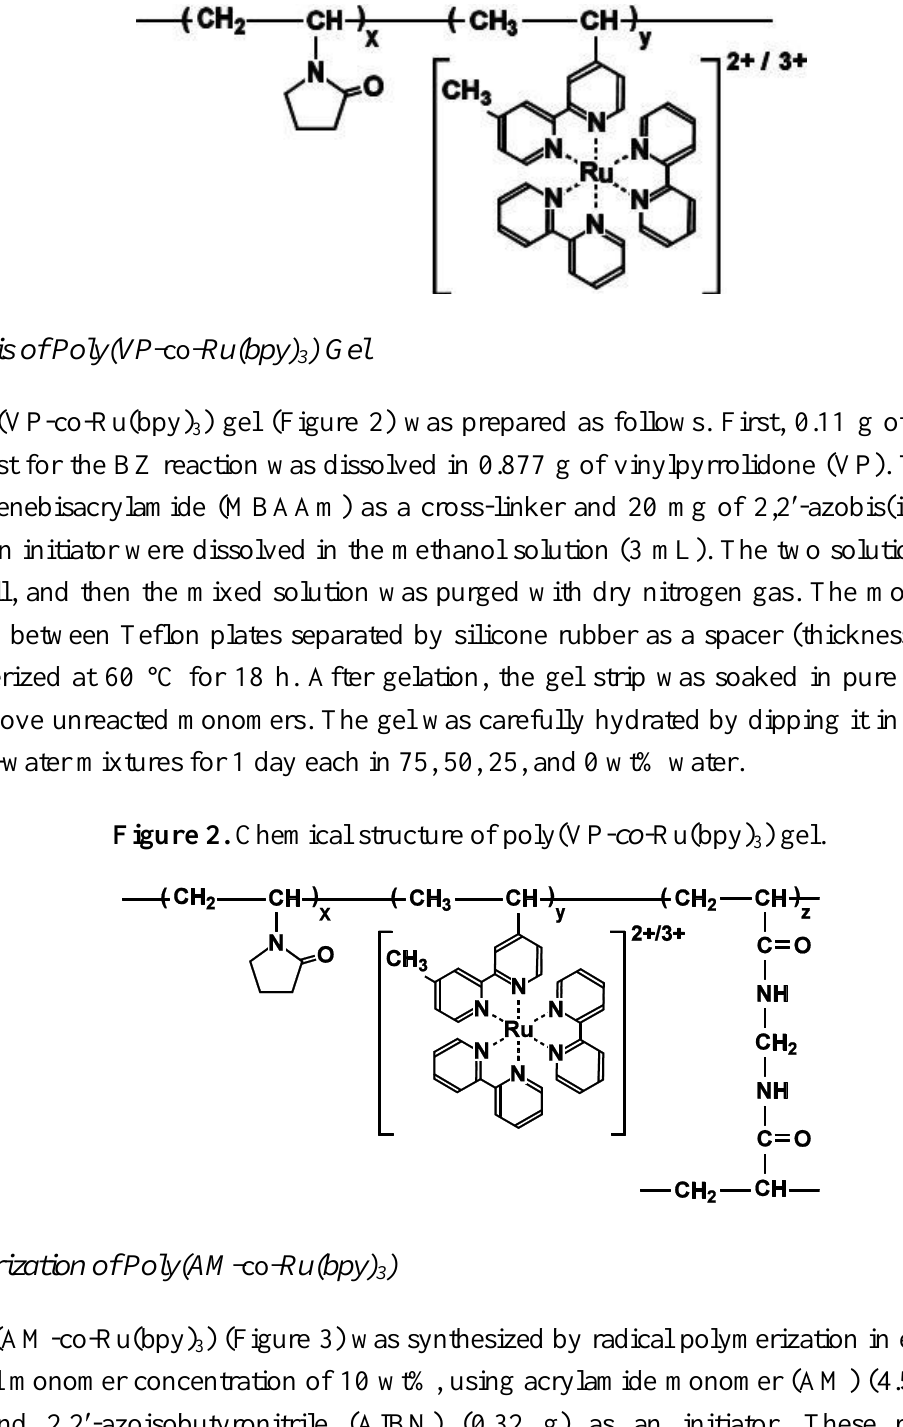
Figure 1. Chemical structure of poly(VP- co -Ru(bpy)